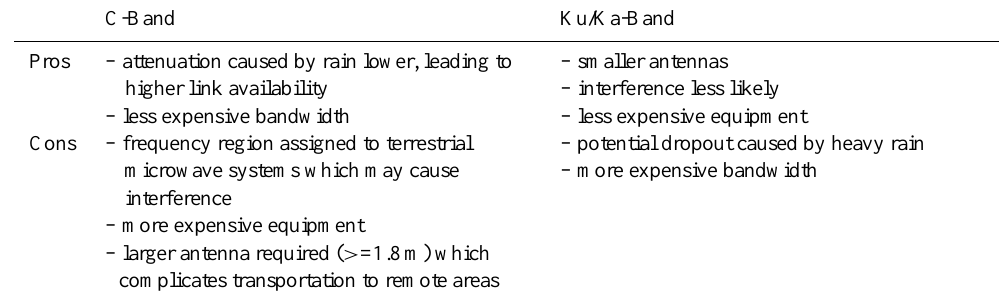
Table 5. Selection of issues considered for deciding the frequency band for sensor communication in GITEWS.